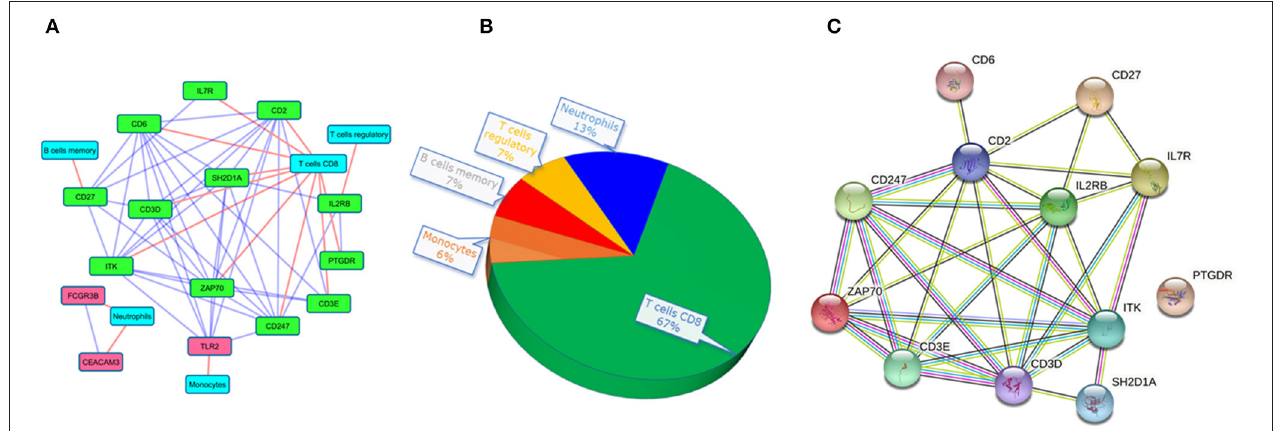
FIGURE 5 | The interaction networks of druggable targets. (A) co-expressed network of druggable targets where red and green colored nodes represent up and downregulated genes. The red edge represents the association of targets to immune cells and the blue edges depict the interaction among the target genes. (B) The pie chart represents the composition of immune cell types with the co-expressed druggable targets. (C) The interaction of the co-expressed druggable targets in the STRING database.